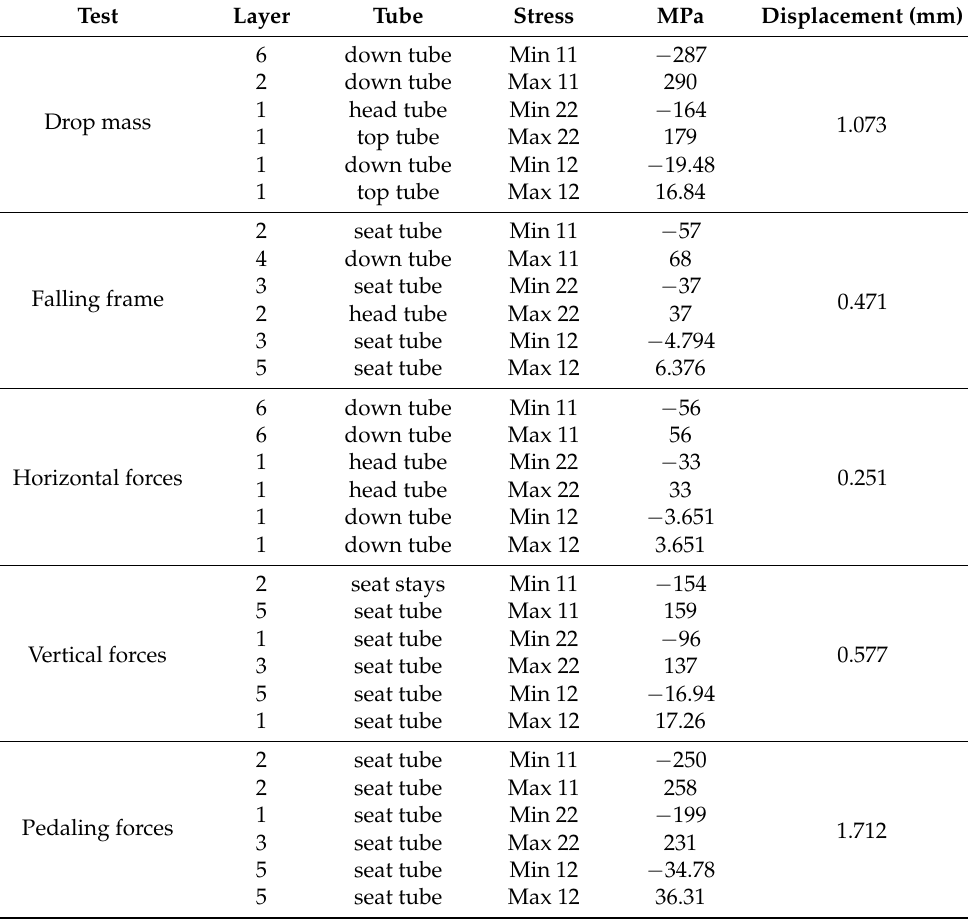
Table 21. Stress and displacement results of stacking scenario